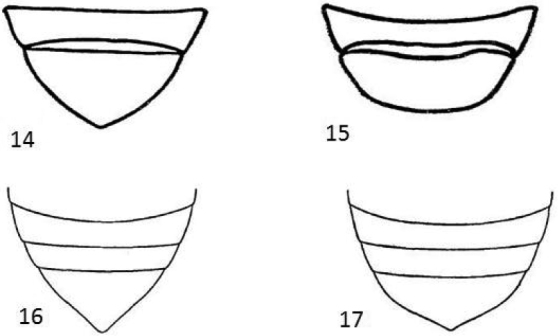
Female last sternite. 14Donaciaclavareaui15D.fukiensis16Donaciakweilina17D.mediohirsuta (Figs 14, 15 original drawings from Cong and Yu 1997, Figs 16, 17 original drawings from Chen 1966).